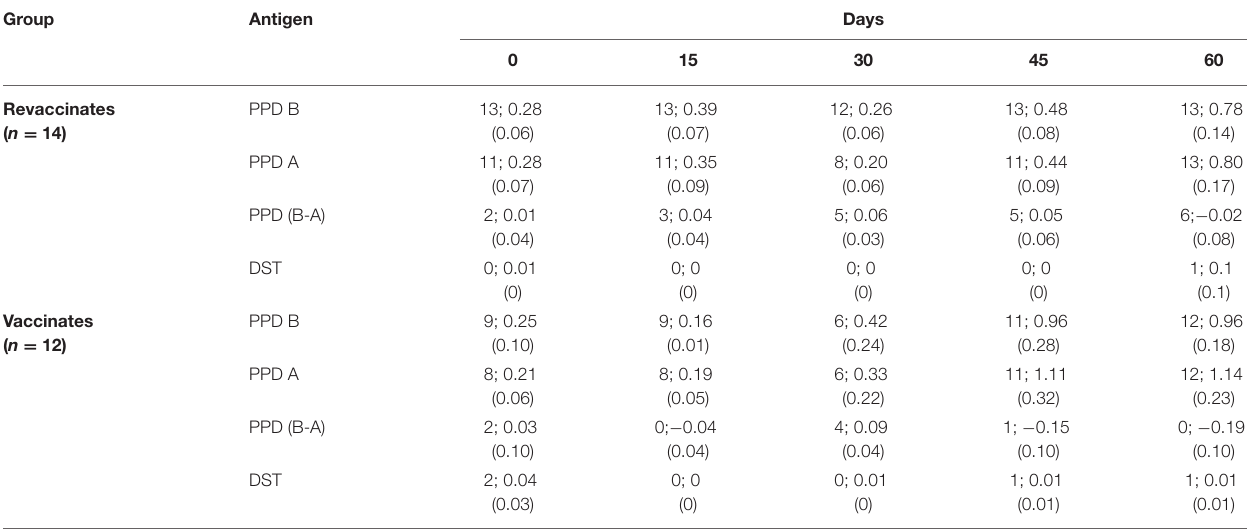
TABLE 1 | The total number of animals that crossed the interferon-gamma release assay (IGRA) cutoff of 0.1 for each antigen tested; mean IGRA responses stimulated by each antigen tested with standard error of the mean is shown in parenthesis.